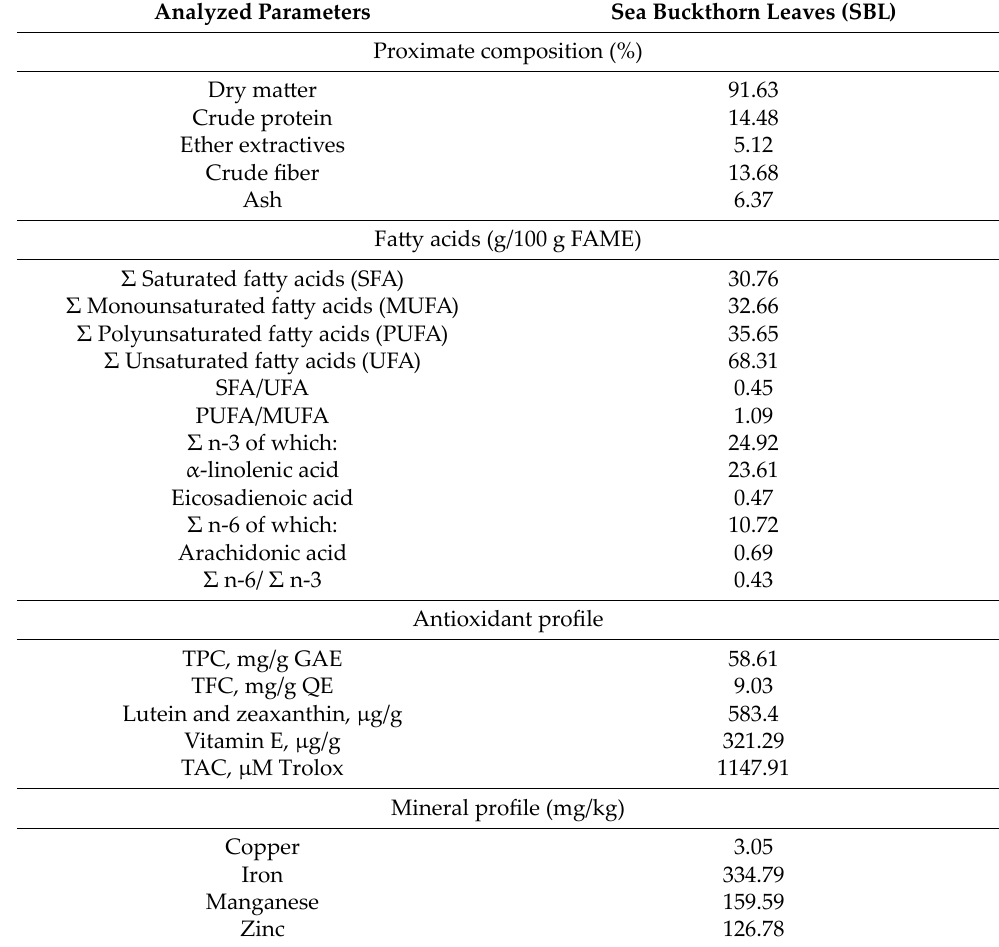
Table 2. Chemical composition of sea buckthorn leaves